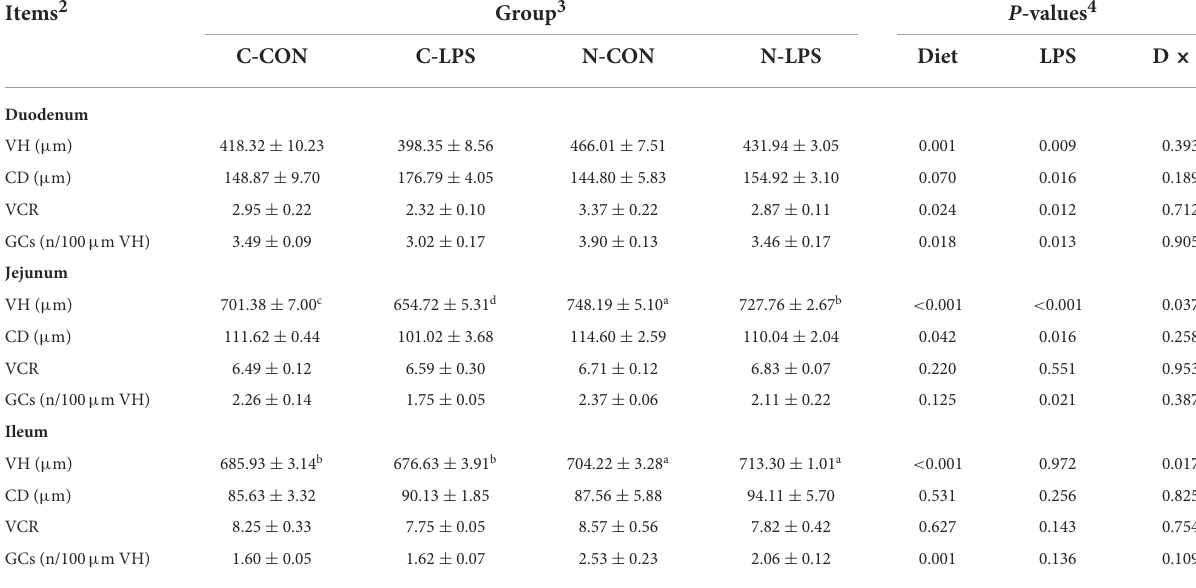
TABLE 5 Effects of maternal nucleotide supplementation on the intestinal morphology and globet cells density in lipopolysaccharide-challenged newborn piglets 1 . Items